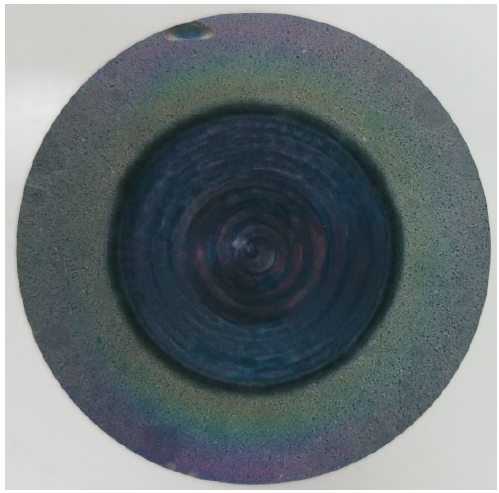
Figure 5. Photograph of a TiO 2 target.